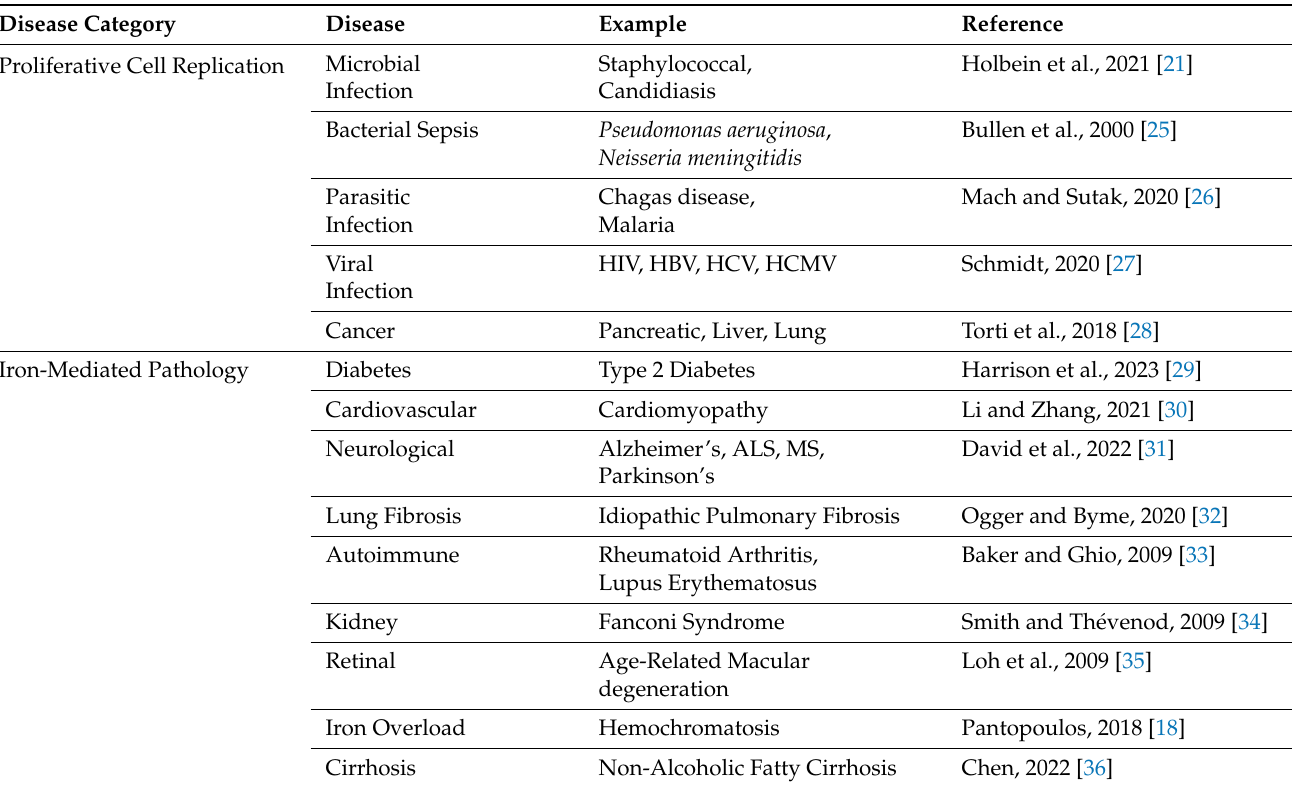
Table 2. Diseases with iron dysregulation.